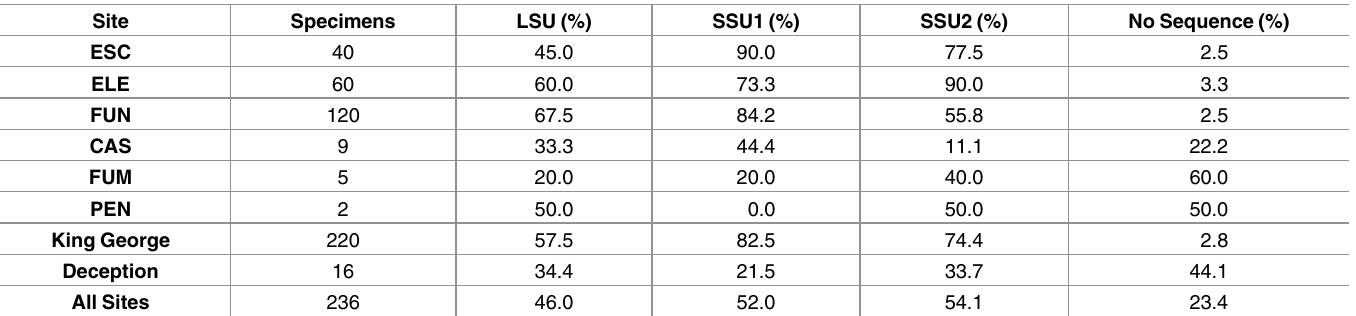
Table 1. Number of specimens sequenced per species for each site and the proportion of specimens that produced a usable sequence for the genes LSU, SSU1 and SSU2, and the proportion of specimens that produced no usable sequences. The final three rows of the table present the num- ber of specimensand the averageproportions for the two islands sampledand for all the sites. Samples were collected duringFebruary 2012 at six sites: Playa Elefantera (ELE), Playa Fu¨nschloger(FUN) and Base Escudero (ESC) all on the Fildes Peninsula of King George Island; and Base GabrielCastillo (CAS), Playa Fumarole(FUM) and Caleta Pendulo(PEN), on